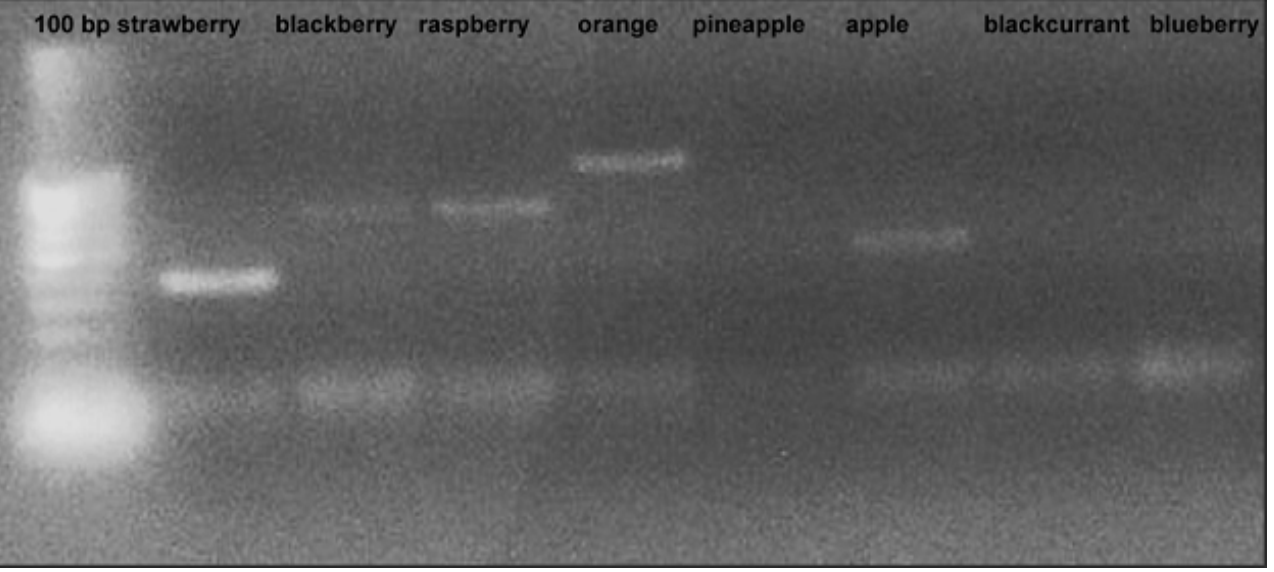
Figure 1. Amplification profile of some DNA samples extracted from “home-made” fruit juices observed with EMFxaANS primers.